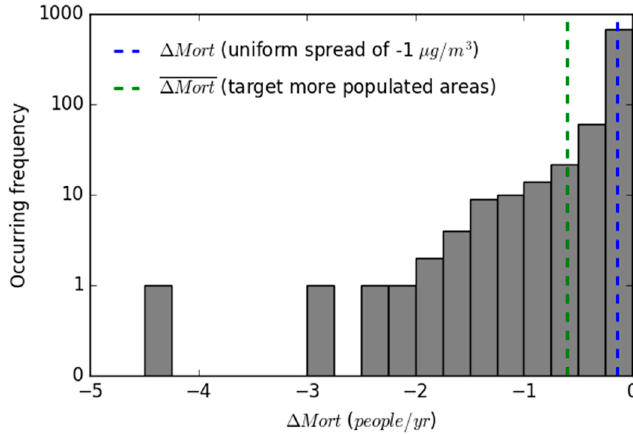
Figure 7. Frequency distribution of Δ Mort of Hong Kong among the 804 tests. The blue-dashed line represents Δ Mort when uniformly reducing PM 2.5 concentration. The green-dashed line shows the mean Δ Mort when PM 2.5 reduction targets more populated areas.